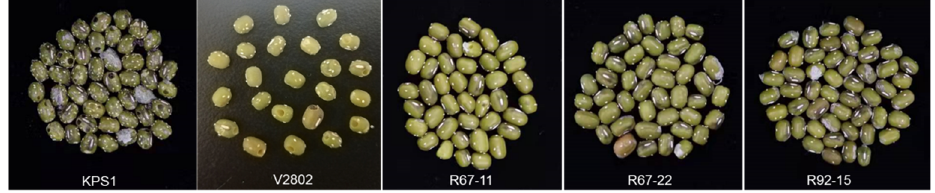
Figure 3. The resistance to C. maculatus of the seeds from R67-11, R67-22, and R92-15 compared with KPS1 and V2802.